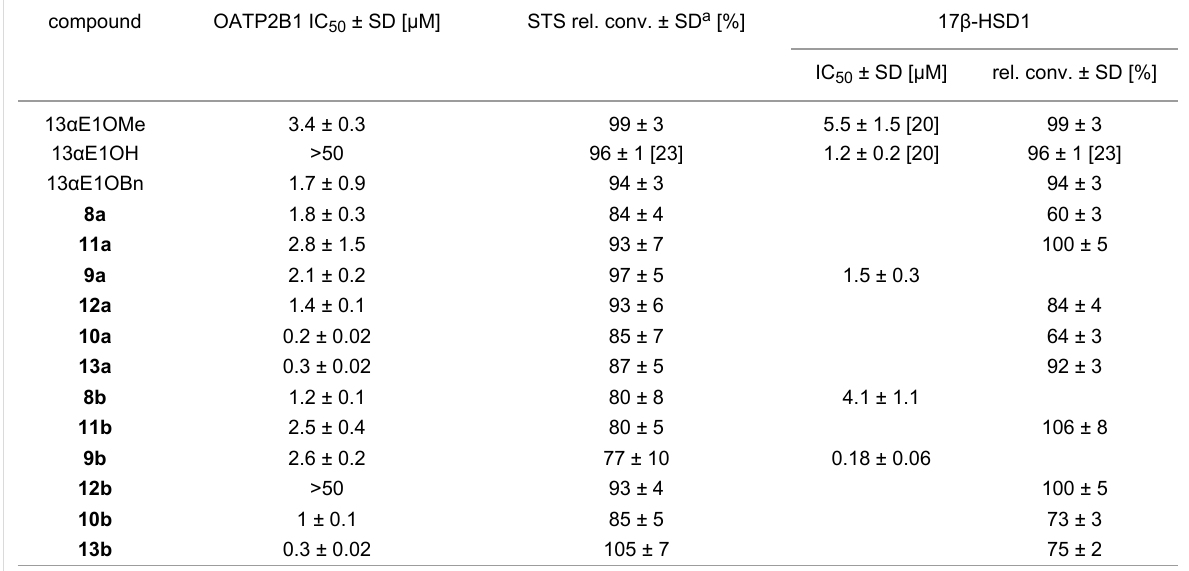
Table 3: OATP2B1, STS and 17 β -HSD1 inhibition data of C–P coupled products 8 – 13 and their basic compounds 13 α E1OMe, 13 α E1OH, 13 α E1OBn.